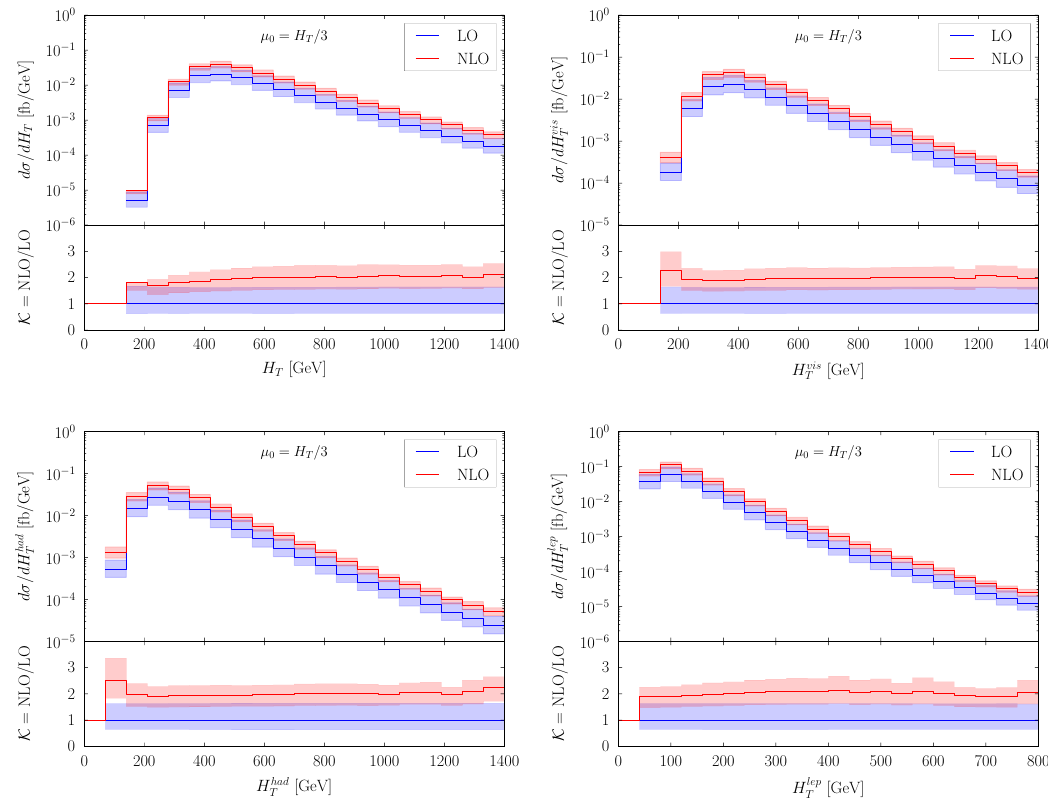
Figure 7 . As in figure 5 but for the H T , H vis